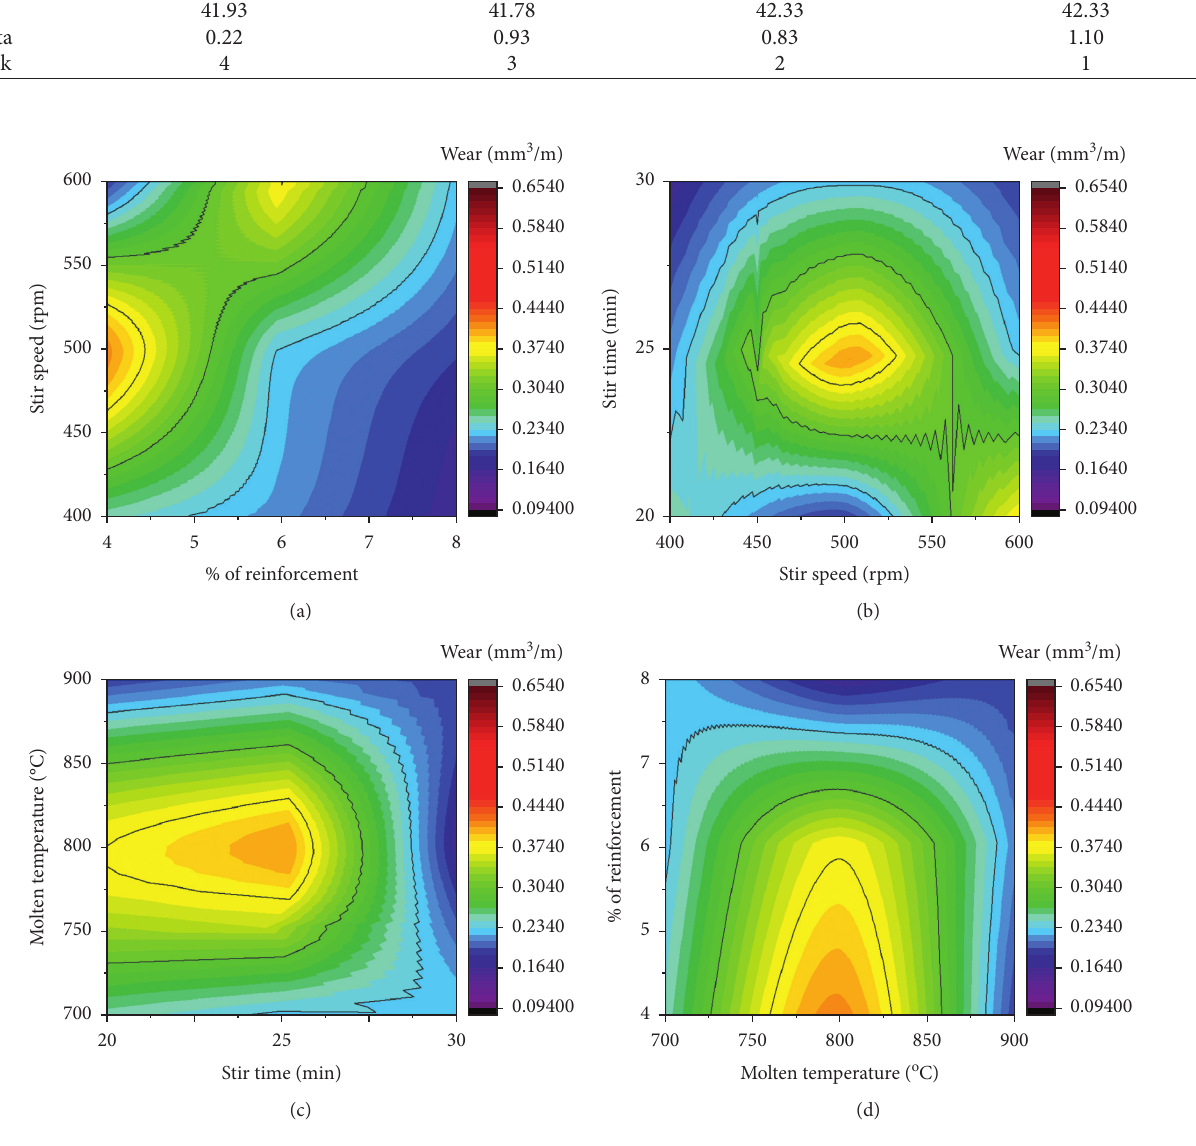
Figure 6: Main effect plot for microhardness test. (a) Means. (b) S/N